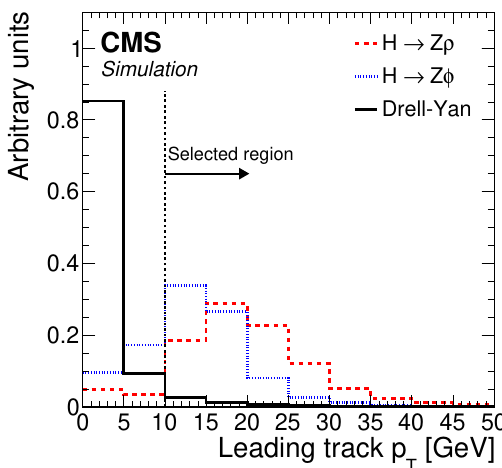
Figure 3 . The transverse momentum distribution for the track that has the larger p two tracks selected as the (cid:26) or (cid:30) candidate. The distribution is shown for events that pass the meson candidate selection described in the text, but not the requirement that one of the tracks must have p > 10 GeV. This distribution is shown for the H → Z (cid:26) decay (dashed red), for the T H → Z (cid:30) decay (dotted blue), and for the background from Drell-Yan events (solid black). All contributions are normalized to the same